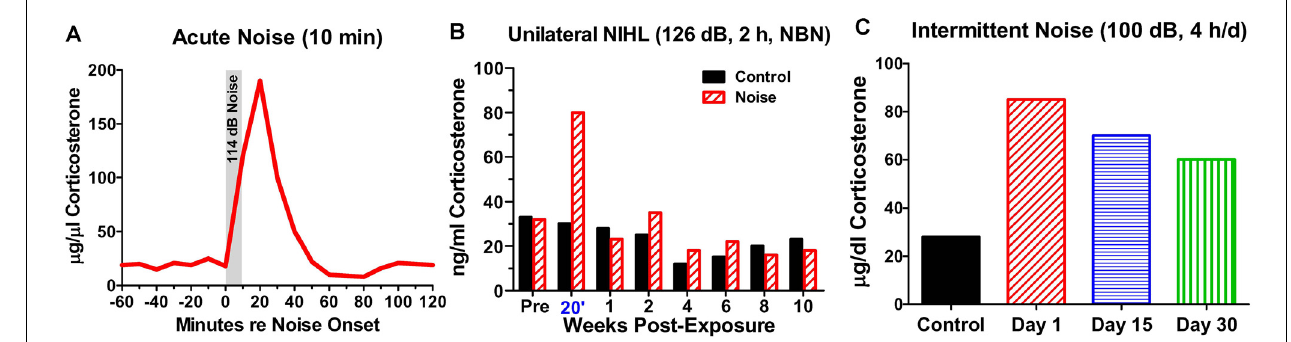
FIGURE 4 | Noise-induced changes in corticosterone. (A) Schematic showing rapid rise and fall of serum corticosterone following a 10-min exposure to white noise presented at 114 dB SPL. (B) Schematic illustrating corticosterone levels measured over 12 weeks in sham control rats and rats exposed unilaterally for 2-h to 126 dB SPL narrowband noise (NBN) centered at 12 kHz. Corticosterone greatly elevated in noise group 20’ post-exposure, but levels decline to normal 1-week post-exposure. No significant difference in long-term basal corticosterone levels between control and noise-exposed group. (C) Schematic illustrating the rise in serum corticosterone following chronic intermittent noise presented at 100 dB SPL for 4-h/day over a period of 30 days. On day 1, corticosterone measured 30-min post-exposure while on day 15 and day 30, corticosterone was measured 24-h after the exposure.